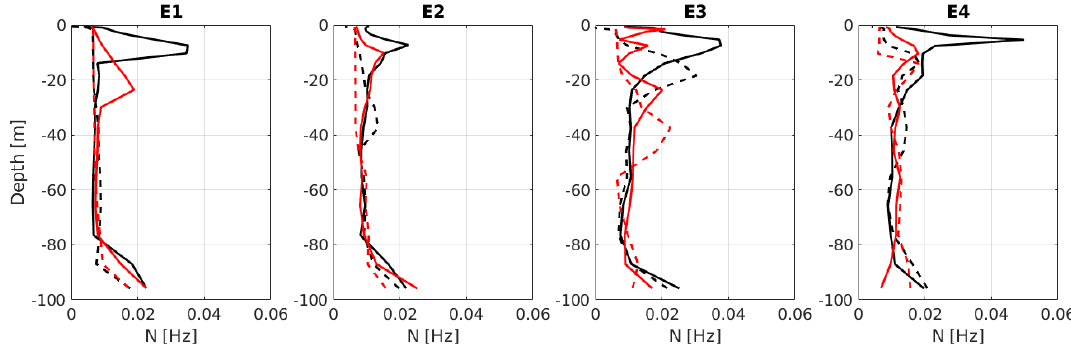
Figure 8. Comparison of the Brunt–Väisälä frequency at the start (solid line) and the end (dashed line) of each wind-jet event obtained from the results of the uncR (in black) and cRS runs (in red) at